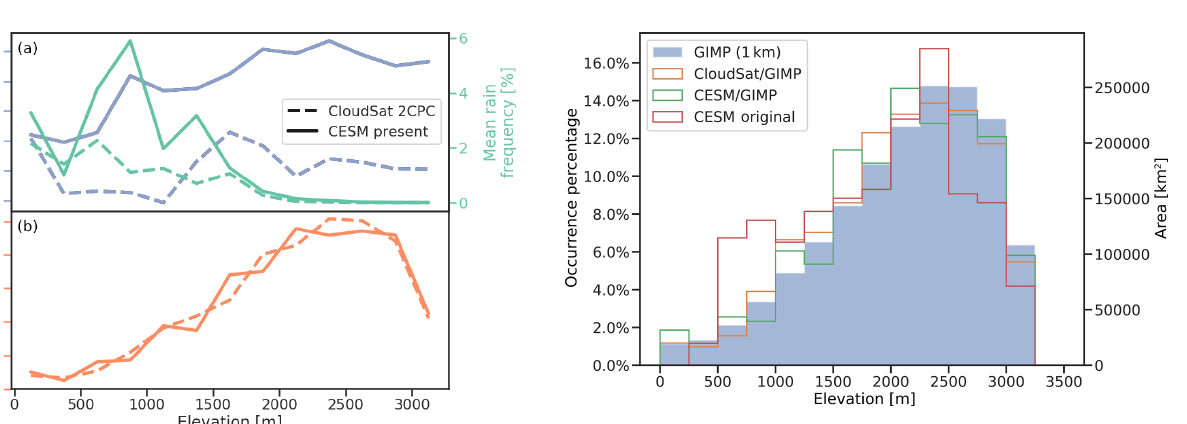
Figure 7. (a) Present-day Greenland Ice Sheet averaged total snow (blue) and total rain (green) frequency in 250m elevation bins based on GIMP topography, according to CloudSat 2CPC (dashed, 2006– 2015) and CESM (solid, 2006–2020). (b) Total ice sheet grid cell surface area in each of these elevation bins according to CloudSat (dashed) and CESM (solid).